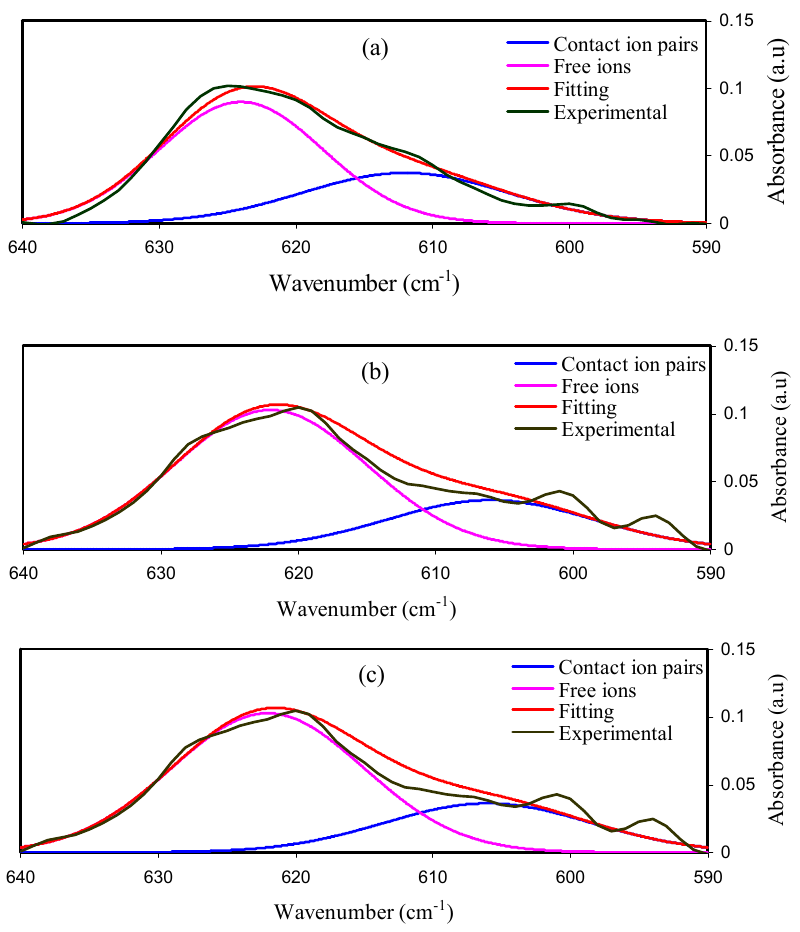
Figure 2. Deconvoluted FTIR spectra for ( a ) MDLG1, ( b ) MDLG2, and ( c ) MDLG3. Table 1. The percentages of ions.